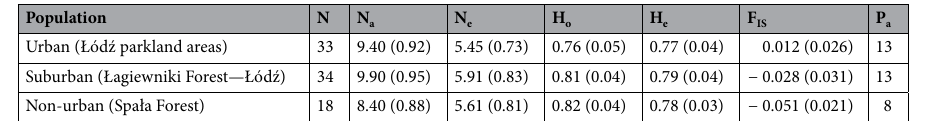
Table 2. Summarized statistics of genetic descriptors for great tits populations including number of individuals (N) per population, number of alleles (N a ), number of effective alleles (N e ), heterozygosity indices (H o and H e ), inbreeding coefficient (F IS ) and number of private alleles (P a ). Mean values with standard errors provided in parentheses were calculated for 10 microsatellite loci. Urban, suburban and non-urban populations are represented by individuals sampled in Łódź parkland areas, Łagiewniki Forest, and Spała Forest, respectively.